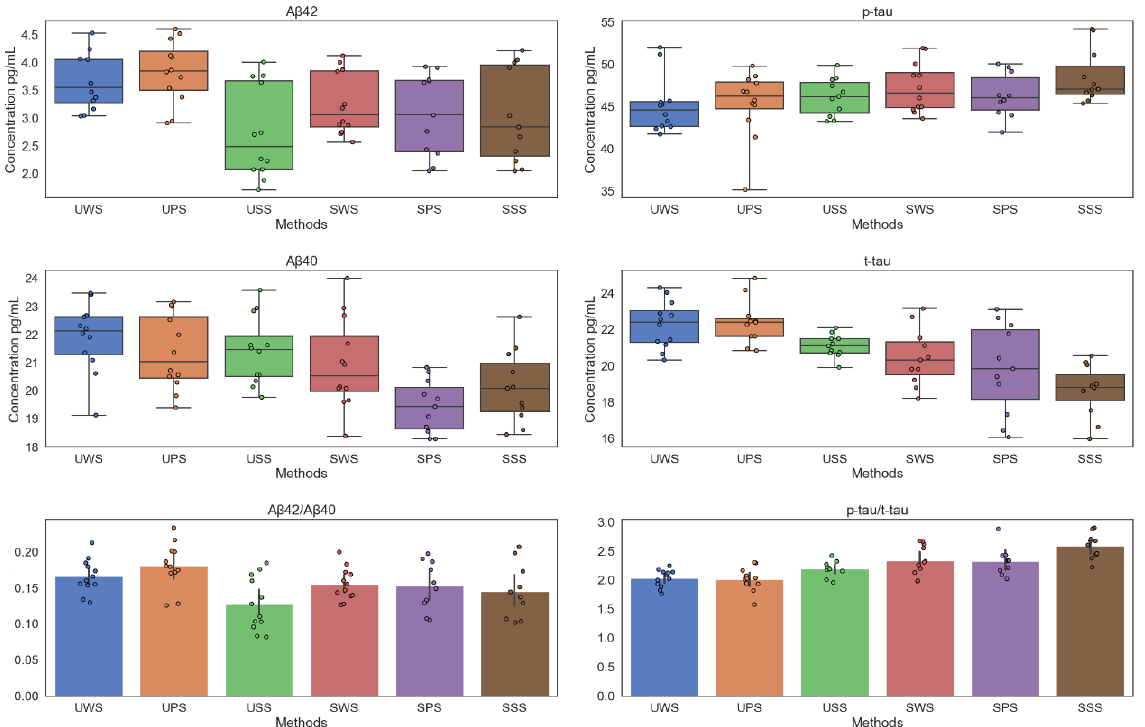
Figure 1. Salivary A β 40, A β 42, t-tau, p -tau, A β 40/A β 42, and t-tau/ p -tau concentrations at different saliva collection methods.